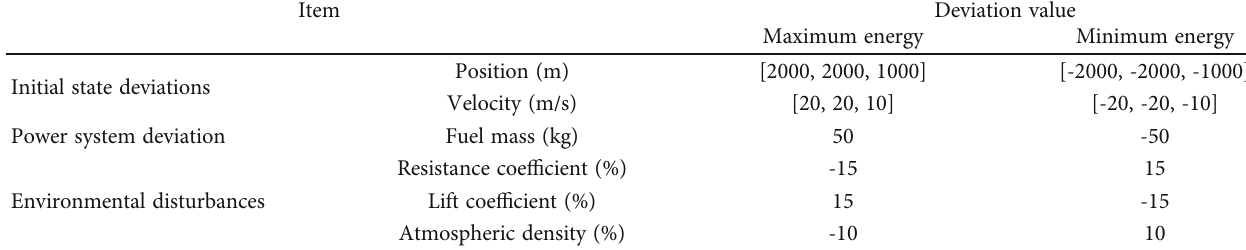
Table 7: Disturbances and deviation conditions.